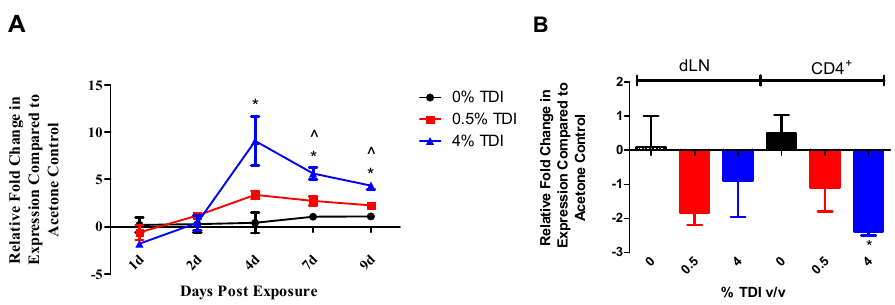
Figure 1. Mature and primary miR ‐ 210 expression increases in the draining lymph node (dLN) and CD4 + subsets following toluene diisocyanate (TDI) sensitization: RT ‐ PCR analysis of mature miR ‐ 210 expression in the dLN at various time points post TDI exposure ( A ); and primary miR ‐ 210 expression in the whole dLN and dLN CD4 + subset four days post TDI exposure ( B ). Cellular purity was assessed via flow cytometric staining for CD4 + Cells (% CD4 + of all cells; Acetone: 89.6% ± 2.2%, 0.5% TDI: 91.5% ± 0.3%, and 4% TDI: 90.4% ± 0.3%). Bars represent mean relative fold change (± standard error, SE) of 3–5 mice per group. Statistical significance is represented by ^ (0.5% TDI) and * (4% TDI) ( p < 0.05) compared to vehicle control.